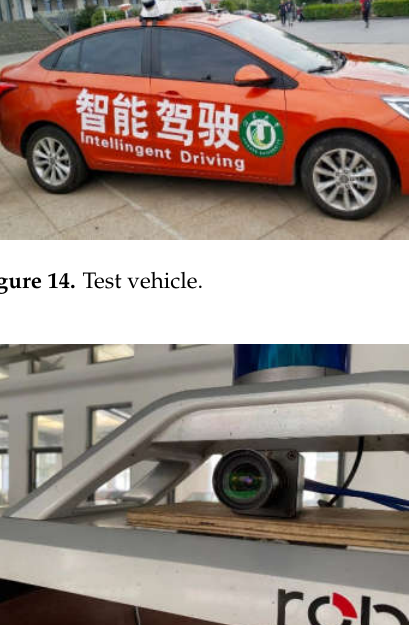
Figure 15. Industrial camera installed effect diagram.